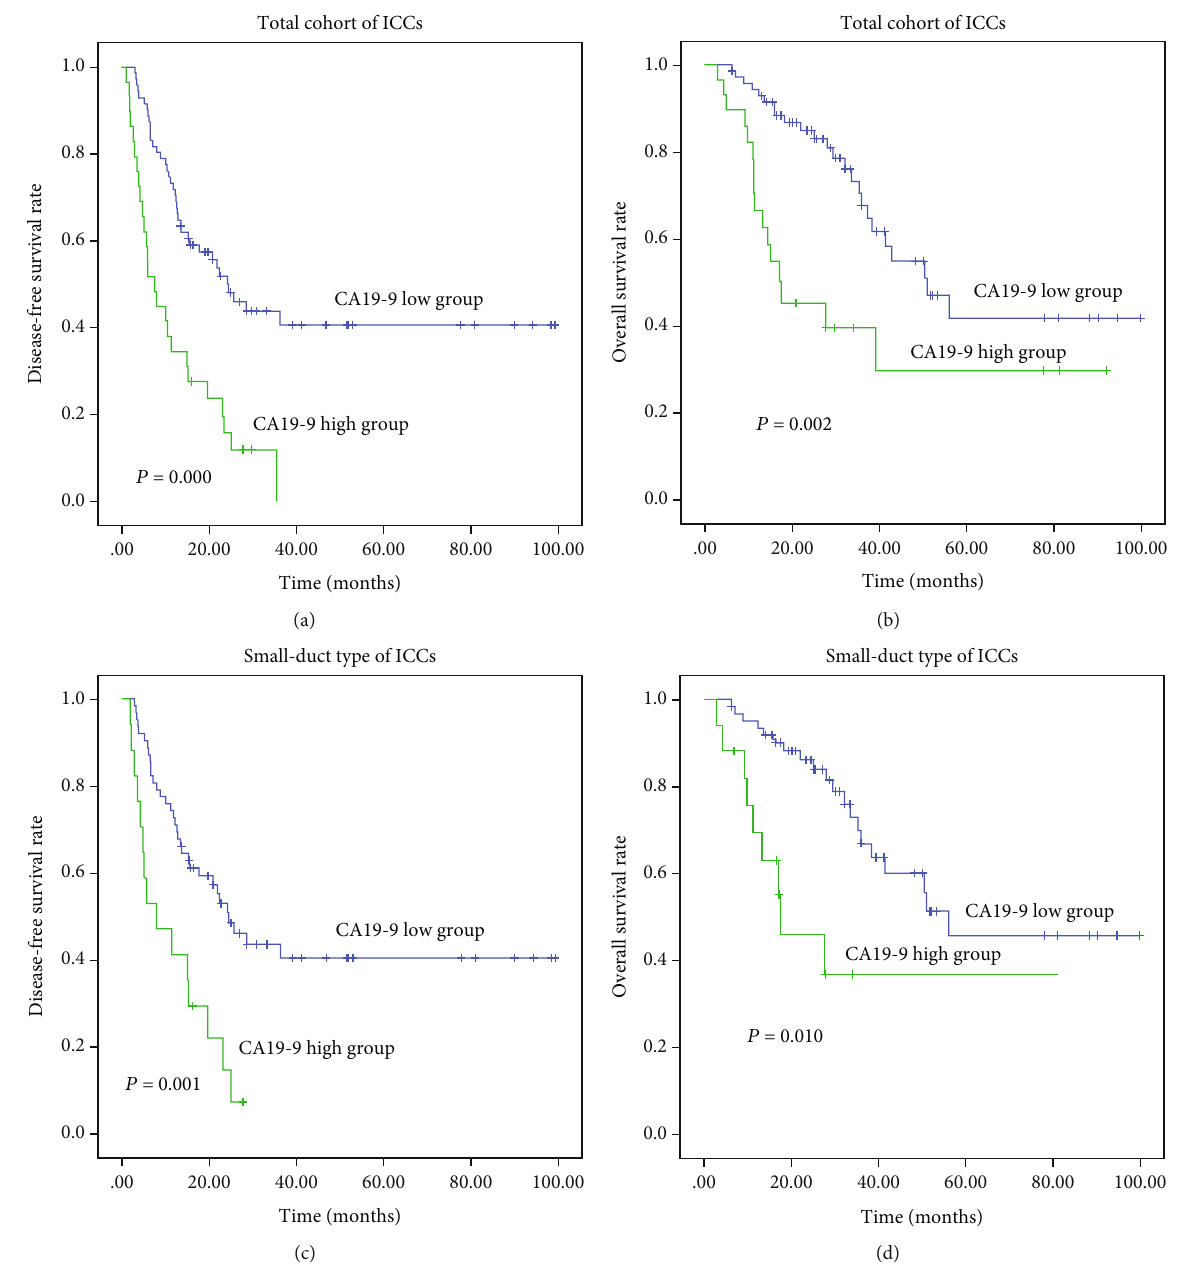
Figure 2: Survival analysis showing patients with high CA19-9 had poor prognosis in ICCs (a) and (b) and their small-duct type (c) and